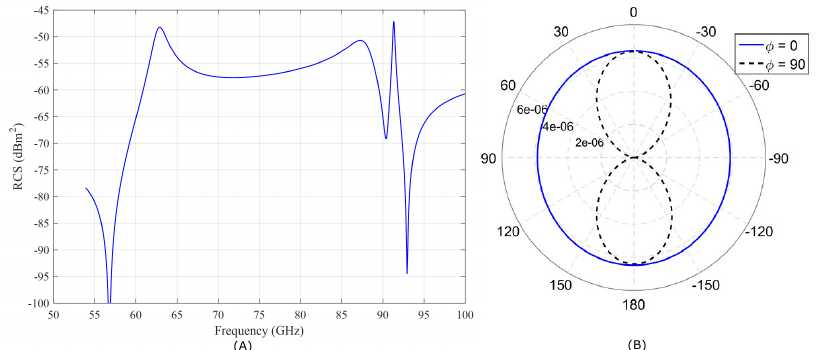
Figure 2. ( A ) The monostatic radar cross-section (RCS) for a single dielectric resonator (DR) tag. ( B ) The bi-static scattering cross-section (m 2 ) for a plane wave incident along the z-axis at 60.24 GHz (resonance frequency) on the plane φ = 0 and π